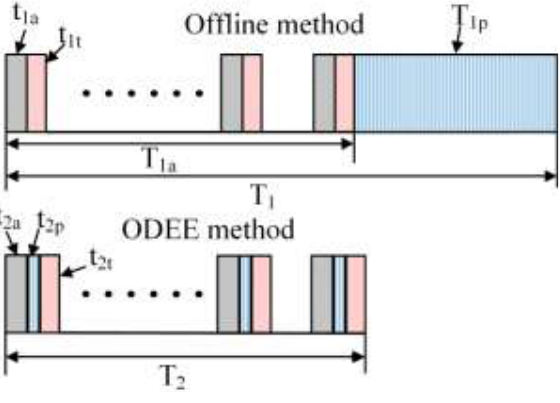
Figure 5. Time consumption comparison between the traditional method and the proposed ODEE